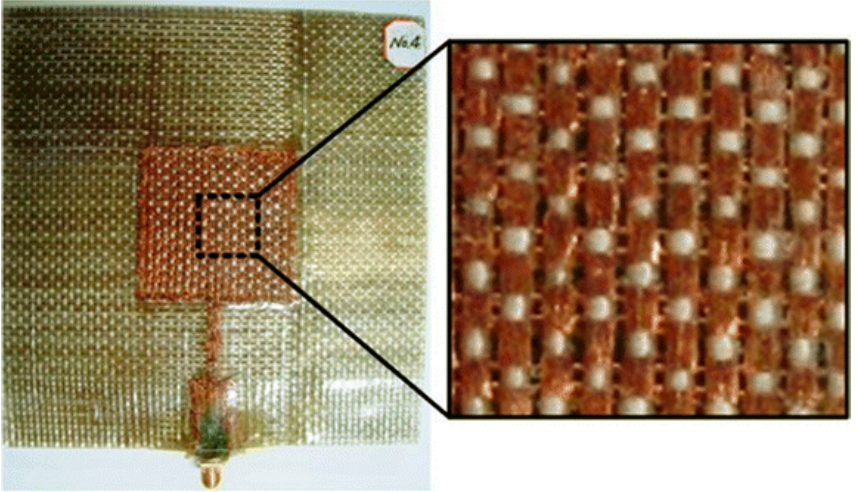
Figure 5. Example of a textile-based implementation of the microstrip patch antenna design using woven copper yarn as a radiating patch and woven glass fabric as the substrate. Reprinted with permission from [71] under the Creative Commons Attribution License.